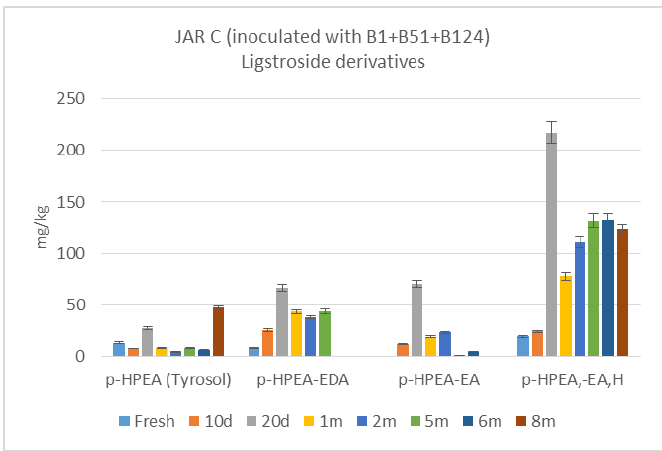
Figure 8. Ligstroside derivatives in the olive flesh during the fermentation.